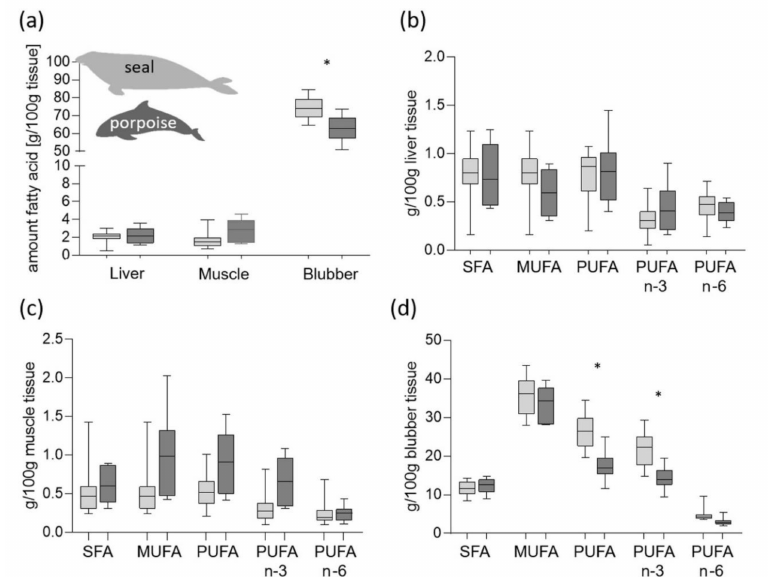
Figure 1. Total fatty acid concentration in the investigated tissues ( a ) and group fatty acid concentrations (sum) in liver ( b ), skeletal muscle ( c ), and blubber ( d ) of grey seals (light grey boxes) and harbour porpoise (dark grey boxes), * significant di ff erent between both species ( p <